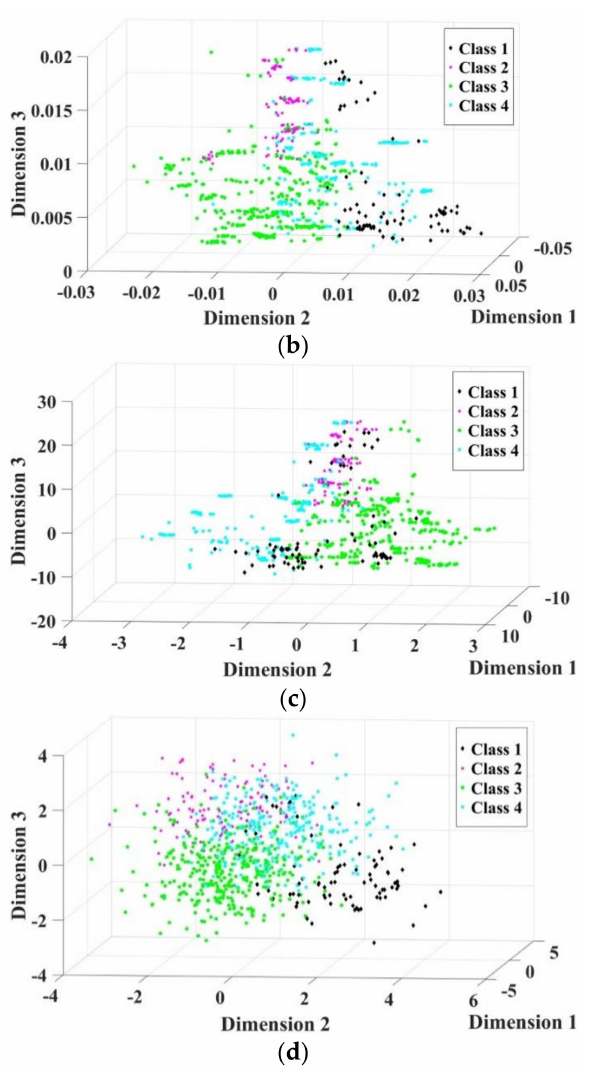
Figure 8. Distribution of 4 classes of faults. Class 1—convex fault; Class 2—concave fault; Class 3—acceleration fault; and Class 4—deceleration fault. ( a ) Distribution of Method 4; ( b ) Distribution of Method 3; ( c ) Distribution of Method 2; ( d ) Distribution of Method